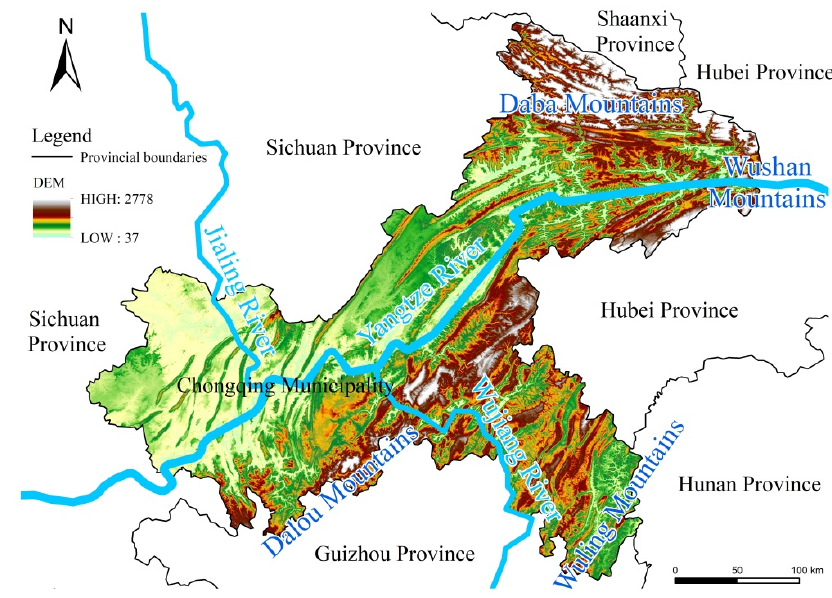
Figure 1. The geographical location and administrative division of Chongqing Municipality.